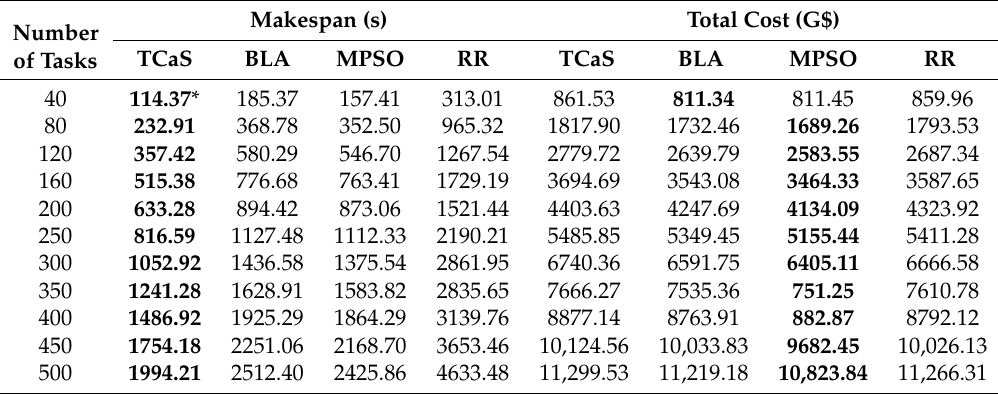
Table 8. Makespan and total cost comparison of the four algorithms.